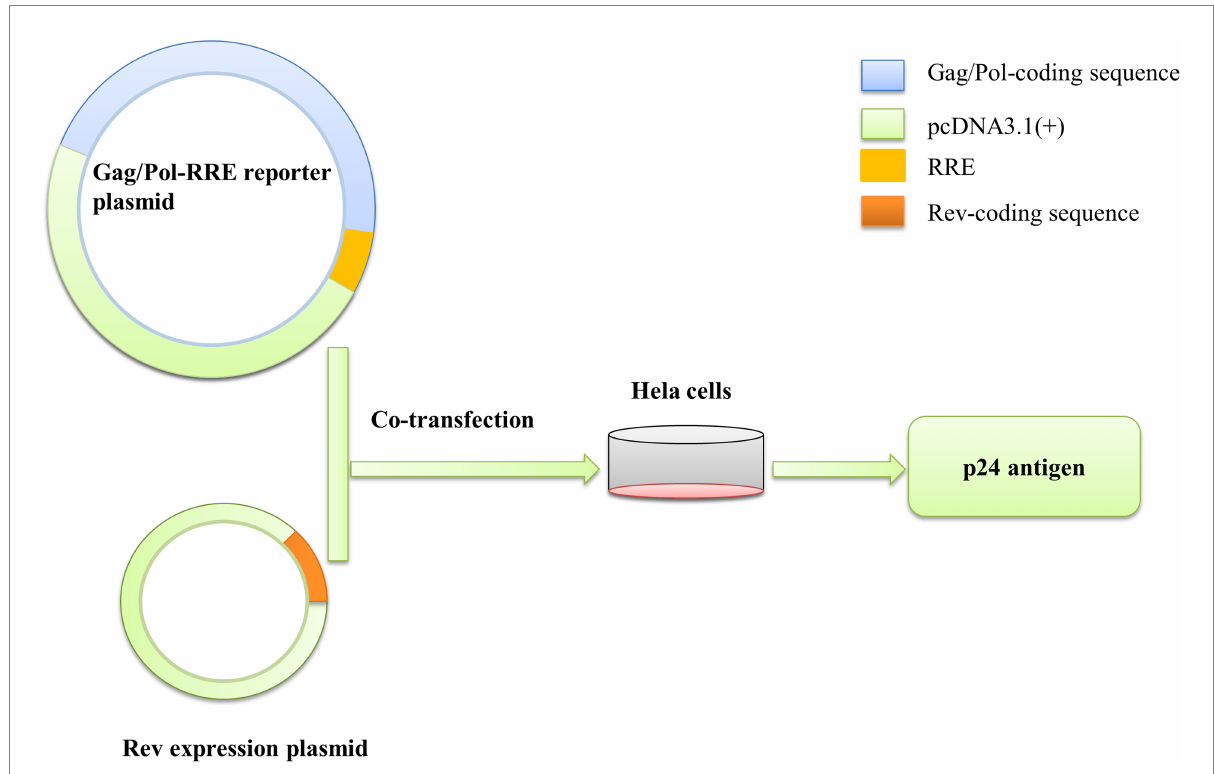
FIGURE 5 Gag/Pol-RRE reporter gene system to assess Rev-RRE functional activity. The Gag/Pol and RRE coding sequences were sequentially linked into the pcDNA3.1(+) vector to construct the Gag/Pol-RRE reporter gene expression plasmid, and the Rev coding sequence was linked into the pcDNA3.1(+) vector to construct the Rev expression plasmid in vitro . The two plasmids were co-transfected into HeLa cells, and the Rev-RRE functional activity was assessed by measuring the expression level of p24 antigen in the cell culture